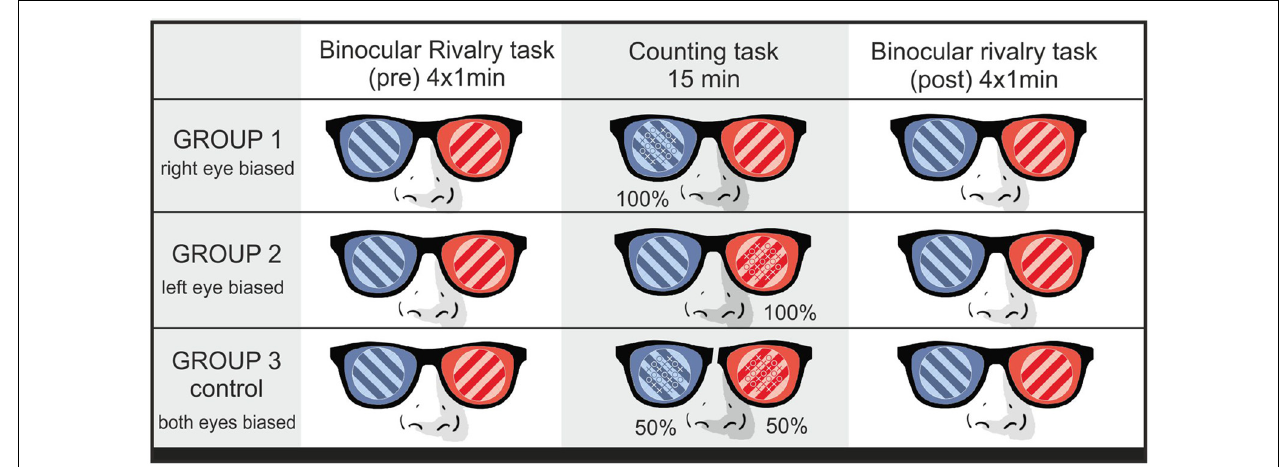
FIGURE 2 | Experiment 1. Sequence of tasks for each group (row).